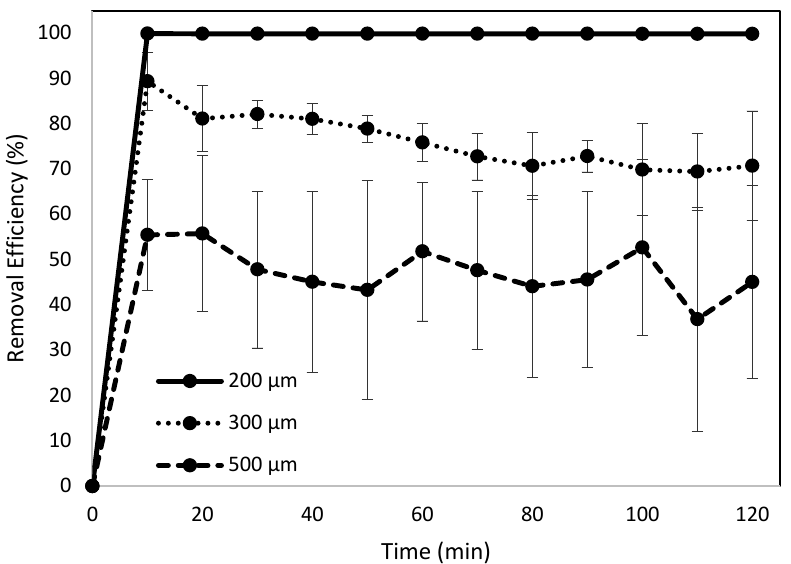
Figure 10. The effects of three different bead sizes on removal efficiency over a 120 min period (voltage = 60 V; flow rate = 1.0 mL/min).